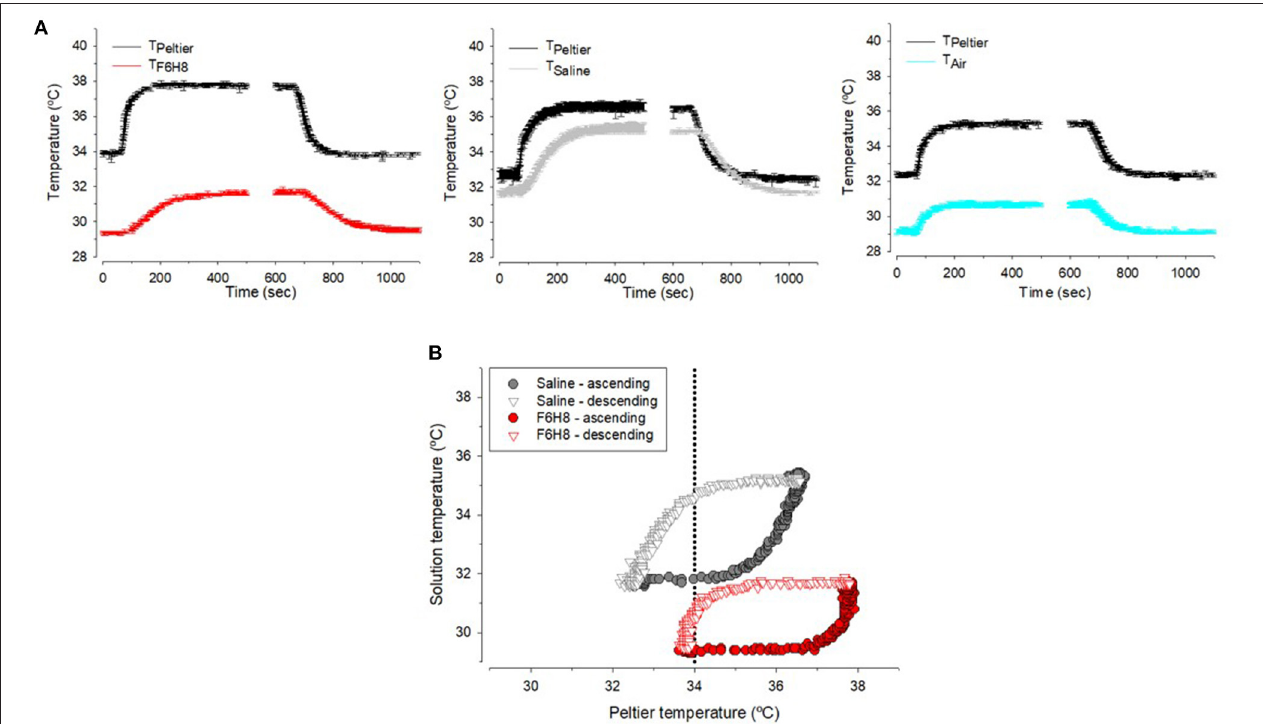
FIGURE 5 | (A) Sample recordings of the temperature measured inside the tube filled with F6H8, saline or empty (air) during experimental warming or cooling in the conditions explained in method and Figure 1D . (B) Hysteresis curves during warming (closed symbols) or cooling (open symbols) inside saline (gray) and F6H8